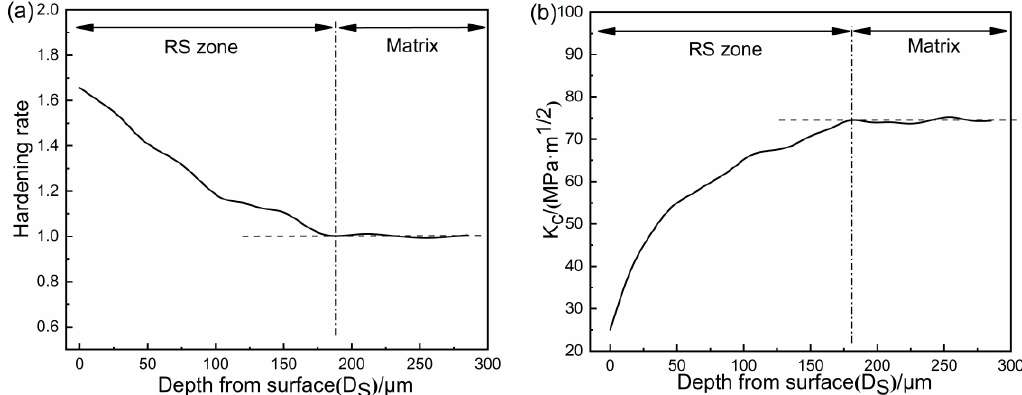
Figure 13. Hardening rate and fracture toughness along with D S distribution: ( a ) hardening rate and ( b ) fracture toughness.